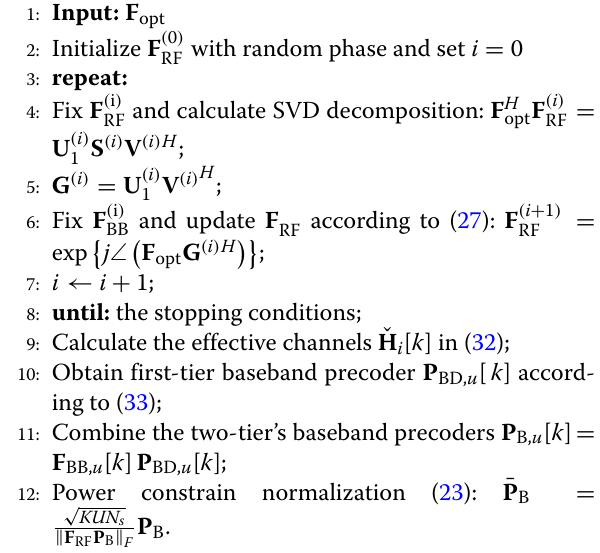
Algorithm 1 Two-tier hybrid precoding